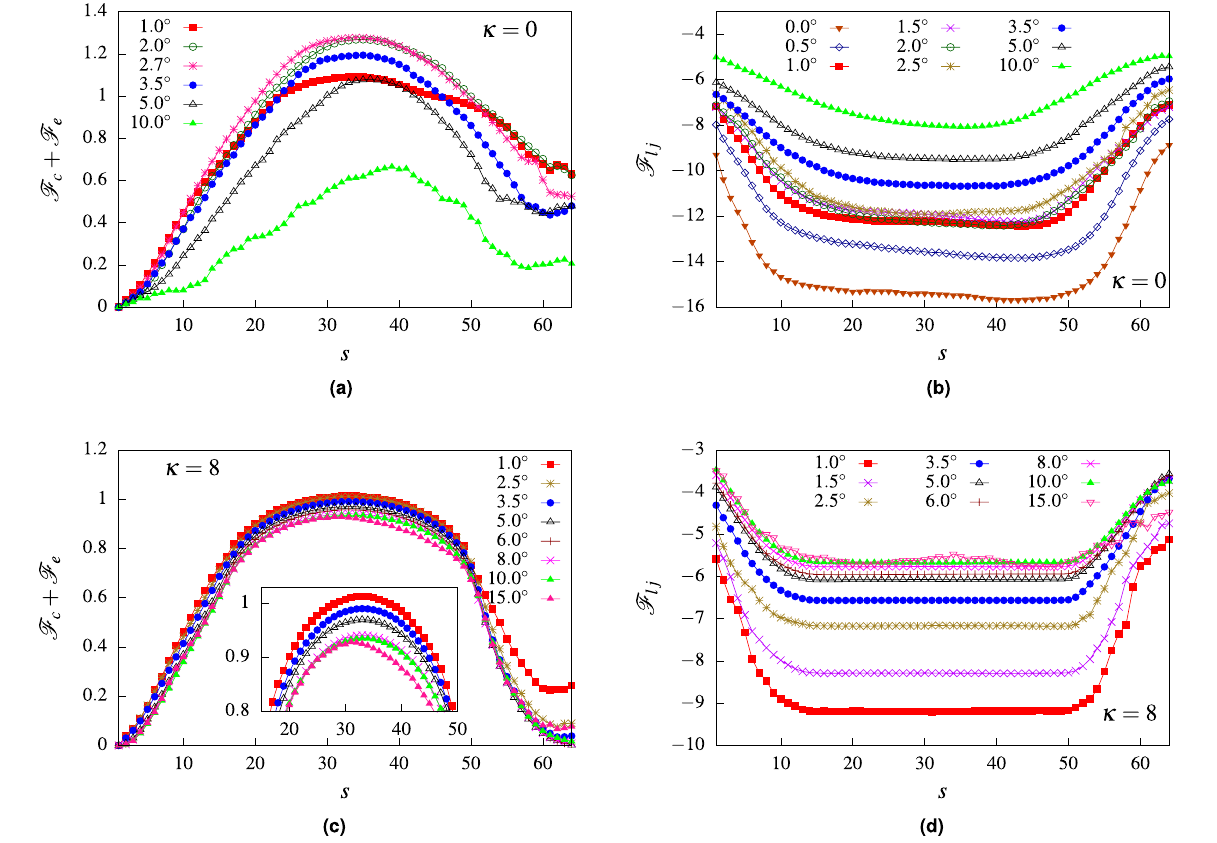
Figure 13. ( a ) Entropic part of the free energy ( F c + F e ) for a flexible polymer as a function of the translocation coordinate s for different α values showing non-monotonic behavior. ( b ) Energetic contribution to free energy for a flexible polymer from surface interactions ( F lj ) as a function of translocation coordinate s for various α values. ( c ) Entropic part of the free energy ( F c + F e ) for a semiflexible polymer ( κ = 8 ) as a function of the translocation coordinate s for different α values showing largely monotonic behavior. (Inset) The barrier height decreases monotonically with α . ( d ) Energetic contribution to free energy for the semiflexible polymer from surface interactions ( F lj ) as a function of translocation coordinate s for various α